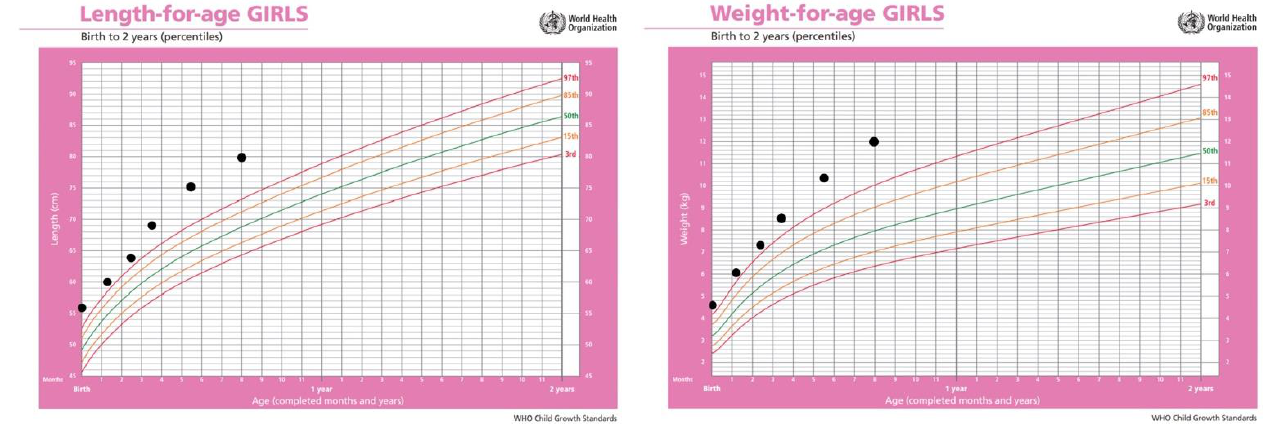
Figure 2. Body length and weight percentile of the patient before first examination by the pediatric endocrinologist, shown on World Health Organization growth charts.